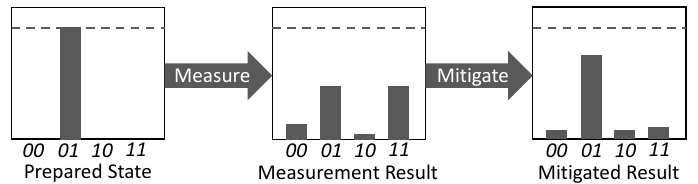
Figure 1. A high-level overview of the readout error mitigation